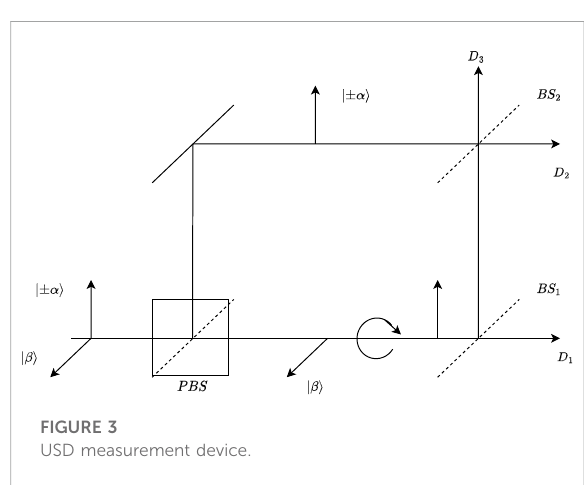
FIGURE 2 Beam splitter is an optical device that can split one beam of light into twobeams.It isakeypart ofmostinterferometers. When two beams of light get into the beam splitter from Input 1 and Input 2 ,respectively,eachofthemwillbesplitintotwobeams. Output Output 1 and 2 will output the interfering results of the split beams.